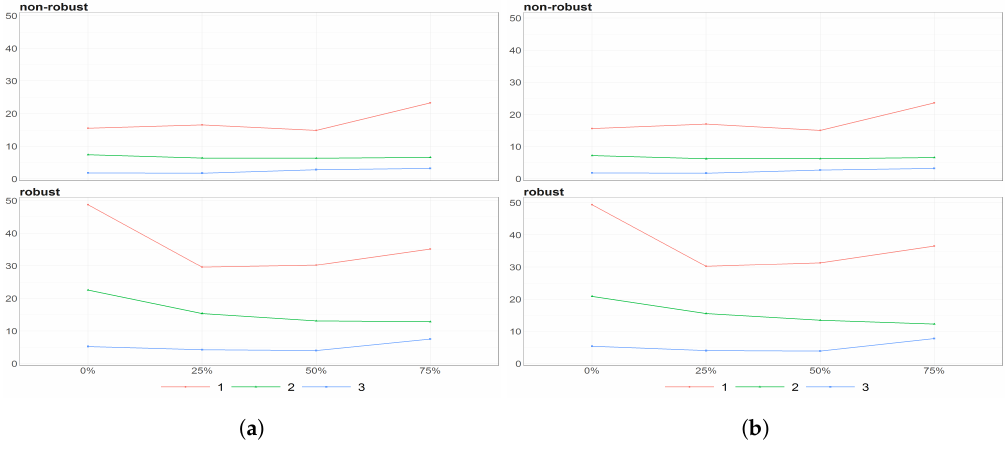
Figure 8. The eigenvalues obtained using PPCA for Females ( a ) and Males ( b ) population of Number of Birthsfor different percentages of maximal missing entries in rows (x axis). Colours of lines corresponds to different eigenvalues, first (light brown), second (dark blue) and third (dark brown) highest. Every subfigure is divided into two subplots corresponding to robust estimation of standard divinations (upper plot) and sample one (bottom plot).